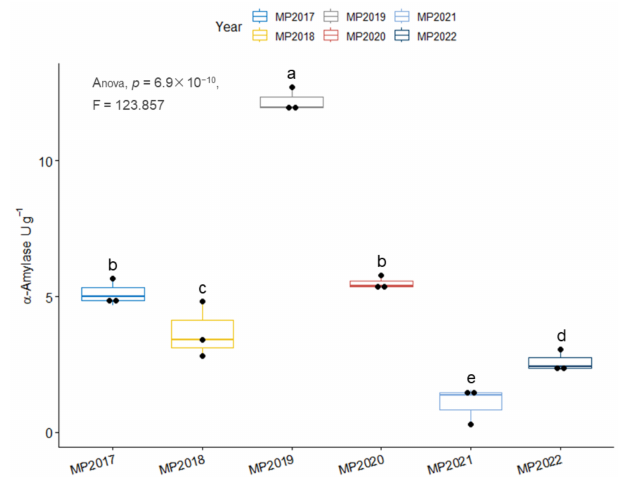
Figure 4. α -amylase activity sorted by storage age. Storage age and α -amylase activity did not substantially correlate using the Pearson correlation test at the 0.05 level. The results of the analysis of the significance of differences between multiple samples, based on Duncan’s multiple range test, are denoted by the lowercase letters a through e, with a denoting the most significant difference and e denoting the least significant difference, at the 0.05 level of significance.